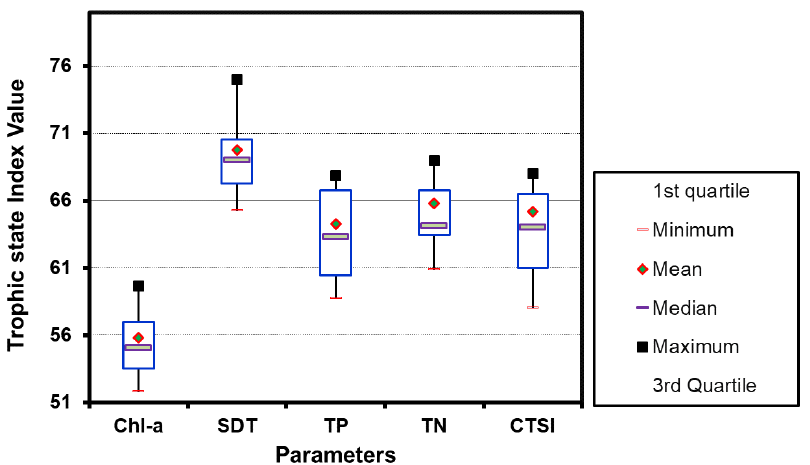
Figure 3. Graphical representation the trophic status of water quality parameters with box and whisker plots.